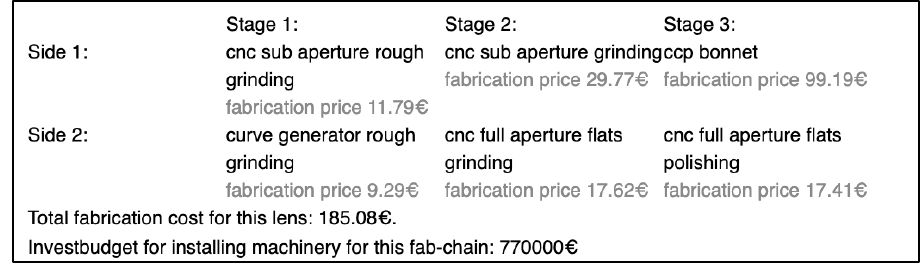
Fig.2. PanDao analysis of the plano-aspherical BK7 lens (Fig.1) with per lens 185 € fabrication cost excluding 8.7 € center grinding cost, 18.5 € coating cost and 18. 2 € testing